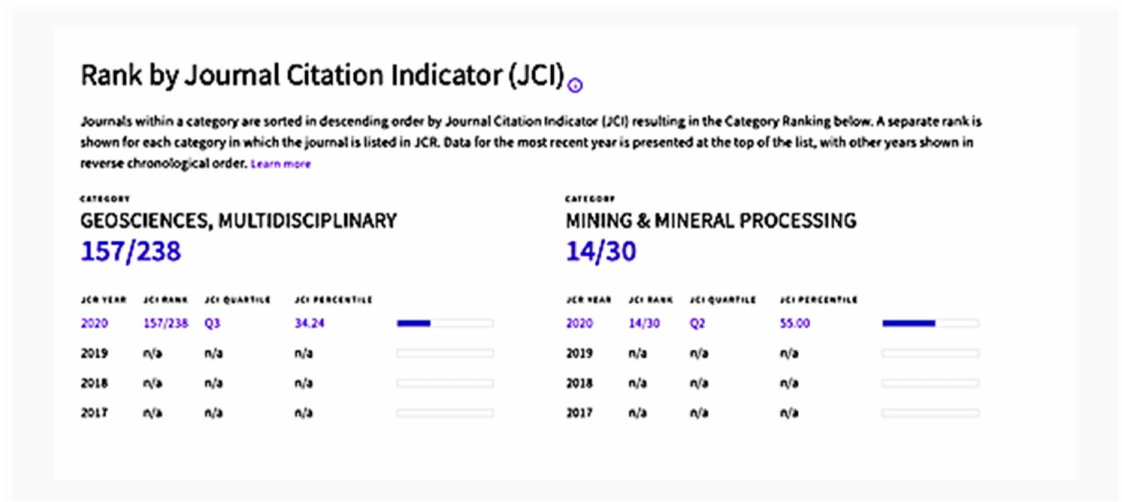
Figure 14. Classification into WoS quartiles based on the JCI values for the analysed journal (take into consideration that some of these journals have IF and are also ranked into quartiles based on the